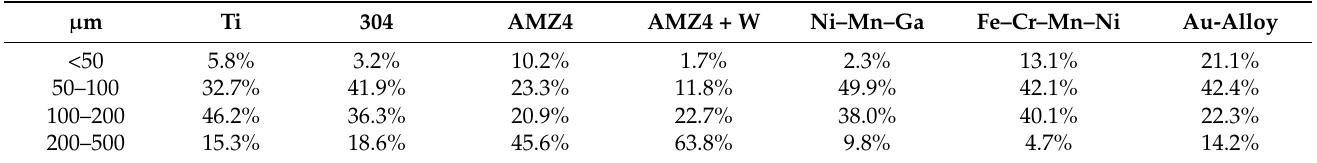
Table 1. Particle size distribution of atomized powders.